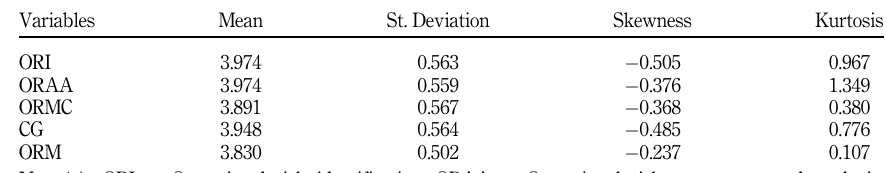
Table 3. Descriptive and normality analysis